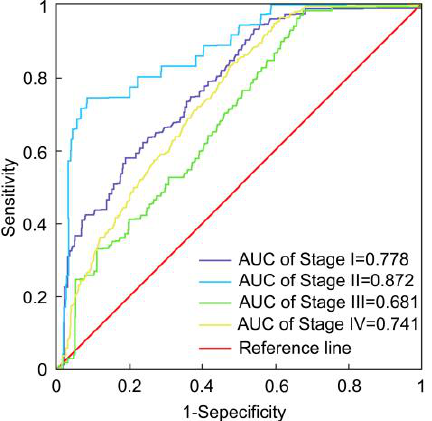
Figure 12. ROC curves and AUCs of the four stages.